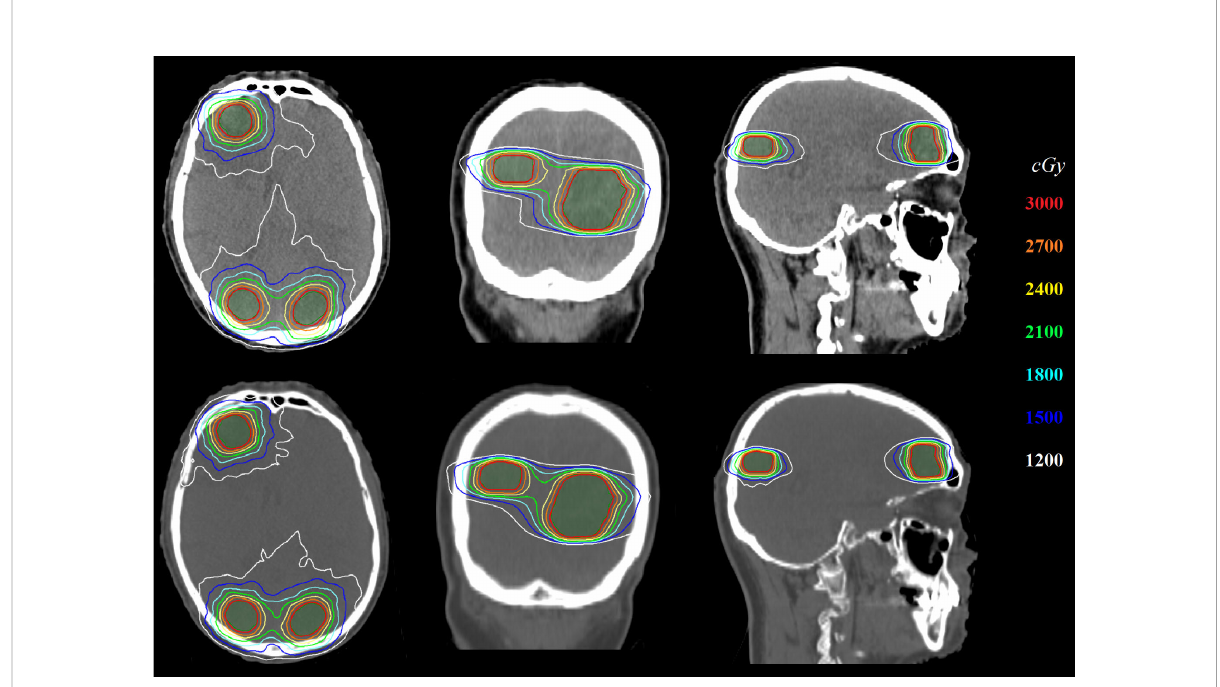
FIGURE 4 Comparison of 2D dose distribution between ST-VMAT (upper row) and SACAO (lower row) for one representative